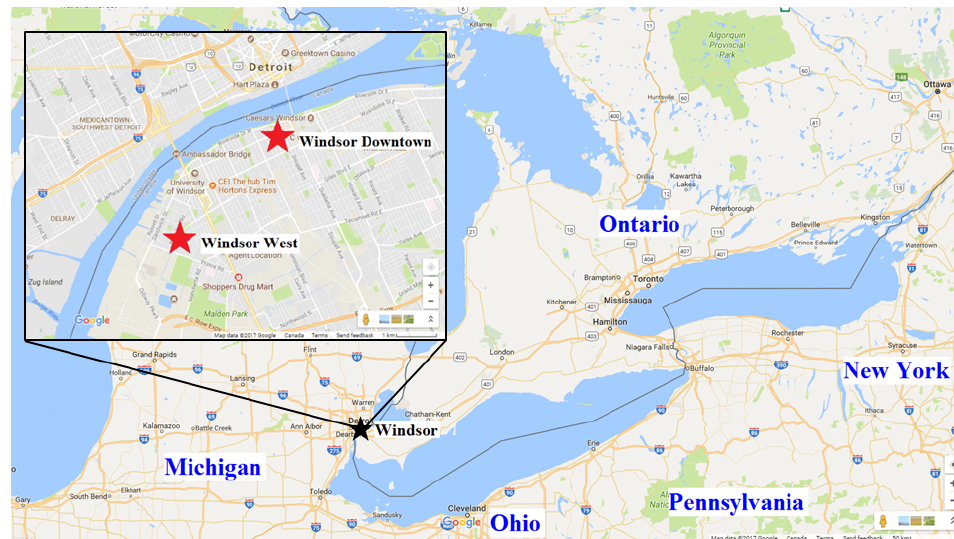
Figure 1. Air quality monitoring stations in Windsor, Ontario,